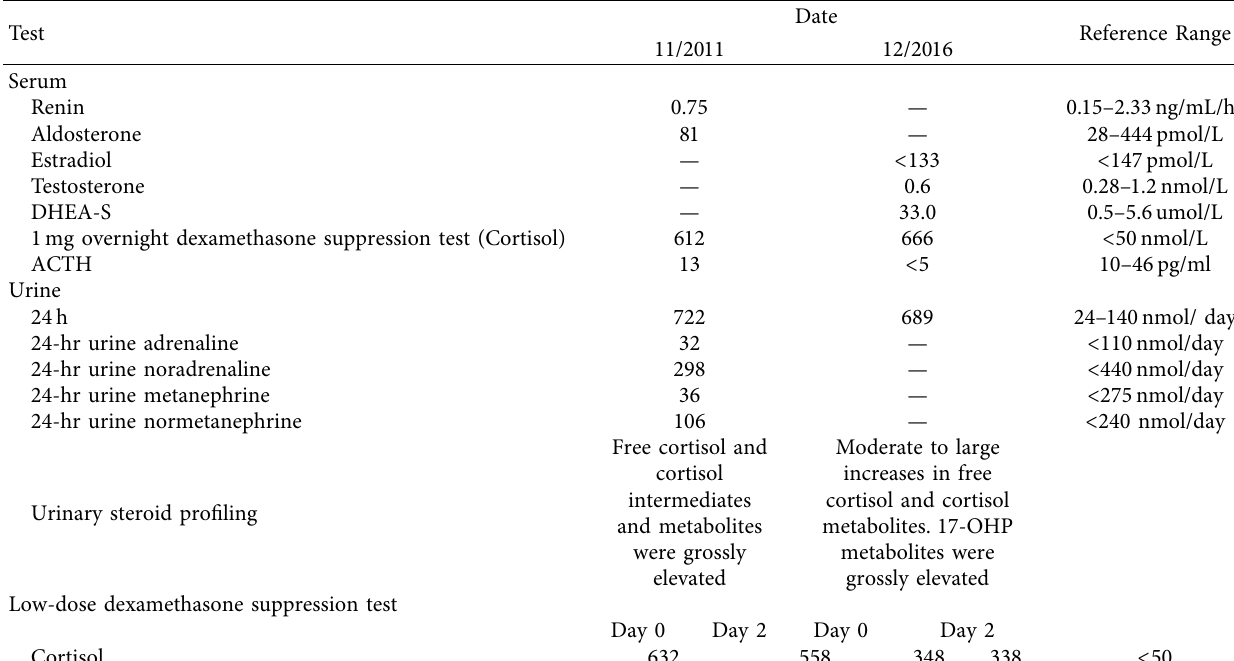
Figure 5: (a) CT pulmonary artery of Patient B on 25 August 2011 showing extensive bilateral pulmonary embolism (red arrow). (b) CT abdomen of Patient B on 13 October 2011. A 3.6 × 3.5 cm lobulated heterogeneously enhancing lesion with a focal calcified spot at the lateral limb of left adrenal with 30HU in pre-contrast scan (blue Table 2: Biochemical investigations of Patient B in 2011 and 2016.